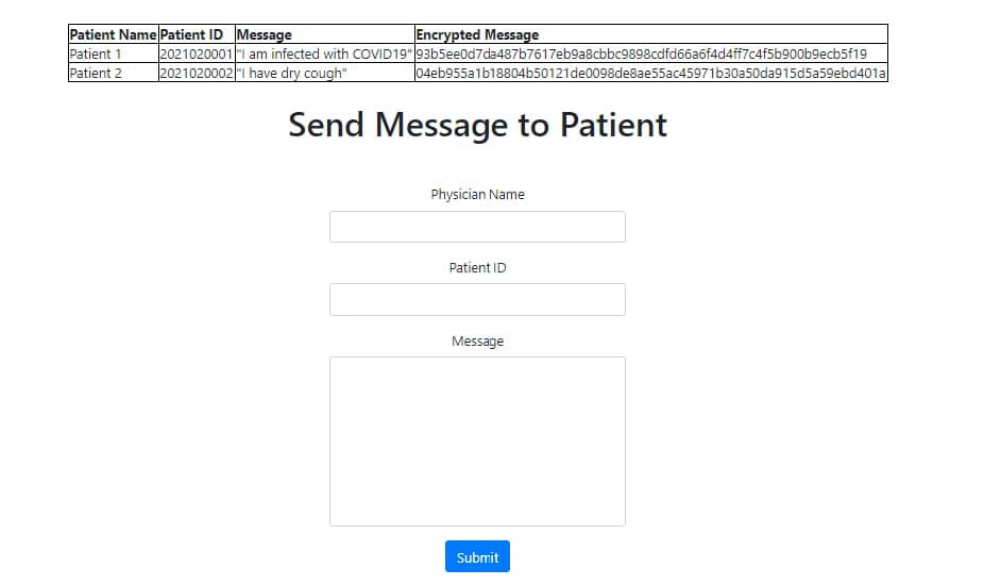
Figure 9. Tele-COVID physician response interface.